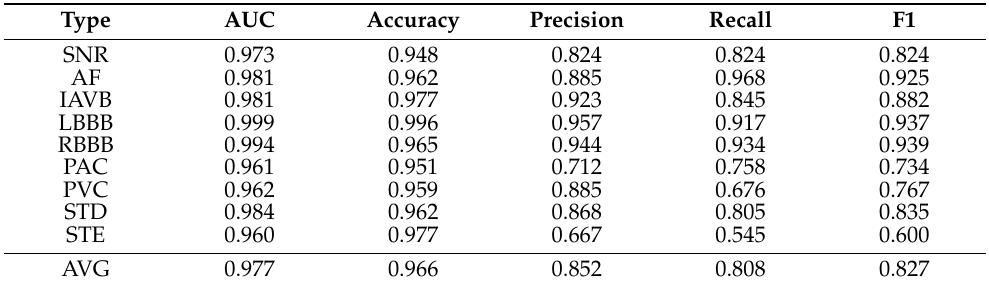
Table 4. The classification performance of the proposed method in CPSC2018.